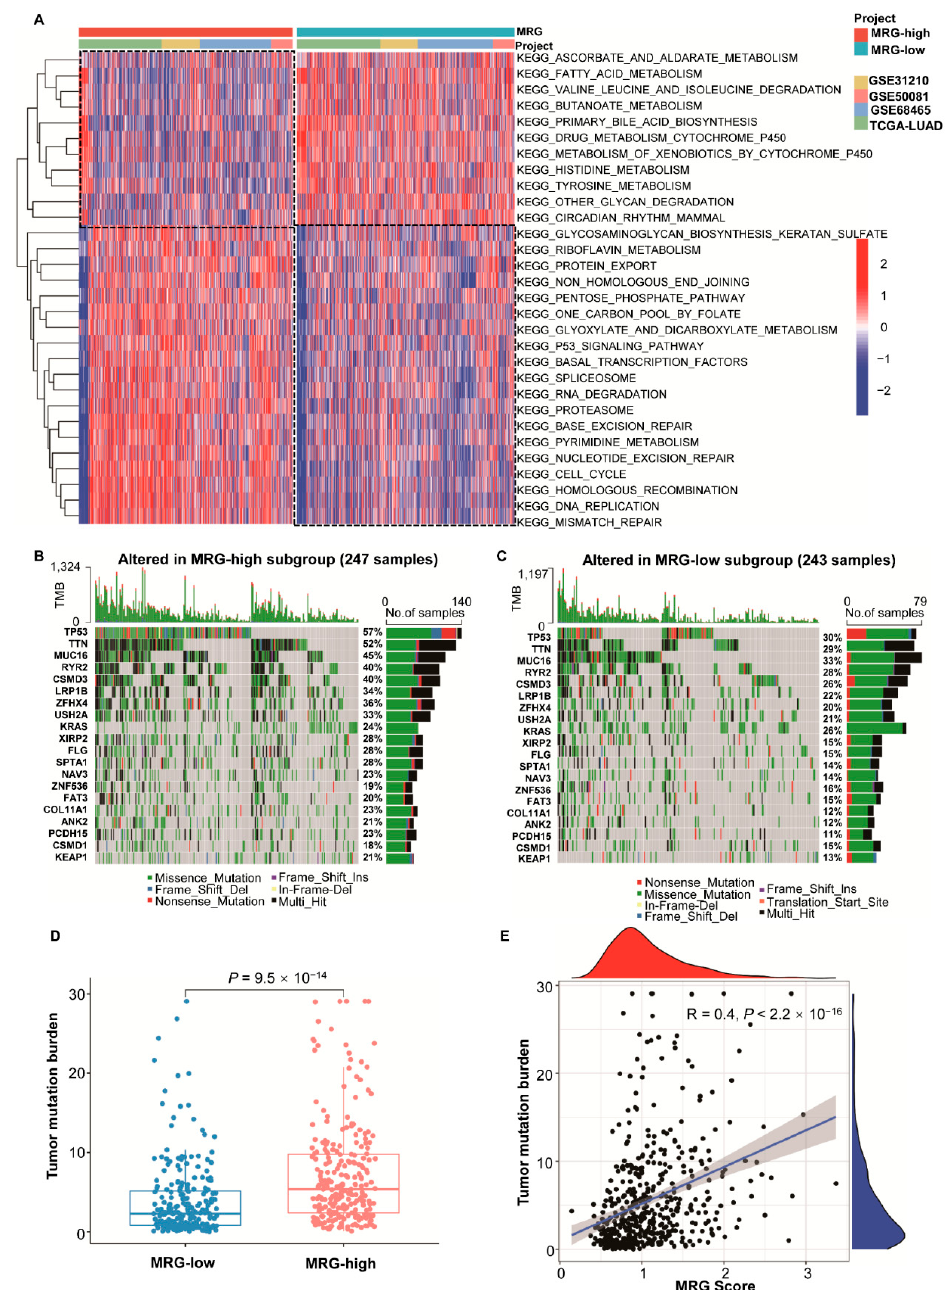
Figure 3. Molecular characteristics of different MRG subgroups. ( A ) Heatmap of Gene Set Variation Analysis (GSVA) of KEGG pathways in individual LUAD patients from TCGA and GEO database. ( B ) Significantly mutated genes in different MRG-high subgroups. Mutated genes (rows, top 20) are ordered by mutation rate; samples (columns) are arranged to emphasize mutual exclusivity among mutations. The mutation percentage is shown on the right, and the overall number of mutations is shown on the top. The color coding indicates the mutation type. ( C ) Significantly mutated genes in different MRG-low subgroups. Mutated genes (rows, top 20) are ordered by mutation rate; samples (columns) are arranged to emphasize mutual exclusivity among mutations. The mutation percentage is shown on the right, and the overall number of mutations is shown on the top. The color coding indicates the mutation type; ( D ) Overall tumor mutation burden (TMB) status in different subgroups. p value is shown in the figures. ( E ) Pearson’s correlation of TMB and MRG score. p value and R value are shown in the